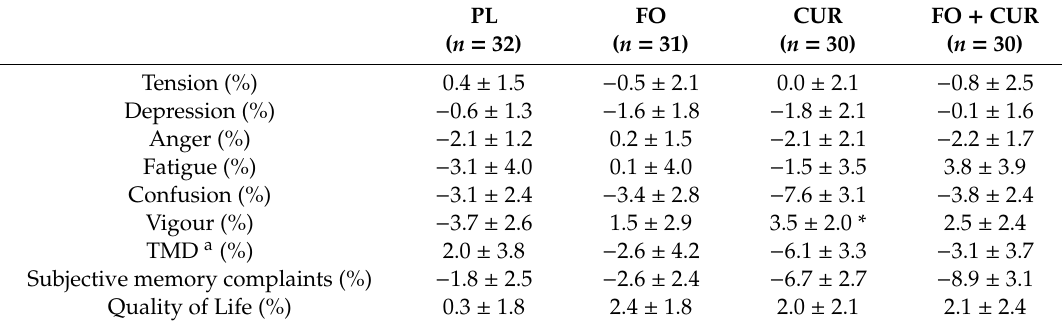
Table 2. Treatment changes in measures of mental wellbeing and quality of life ( n =